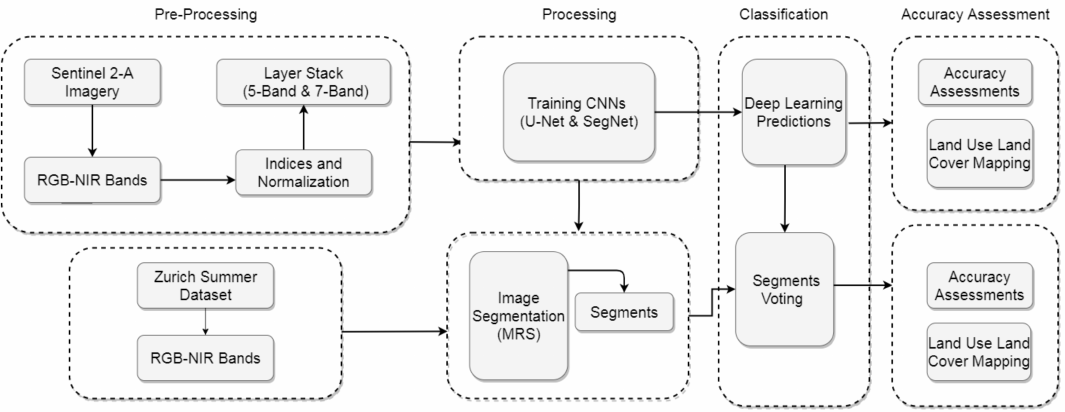
Figure 6. Flowchart of the